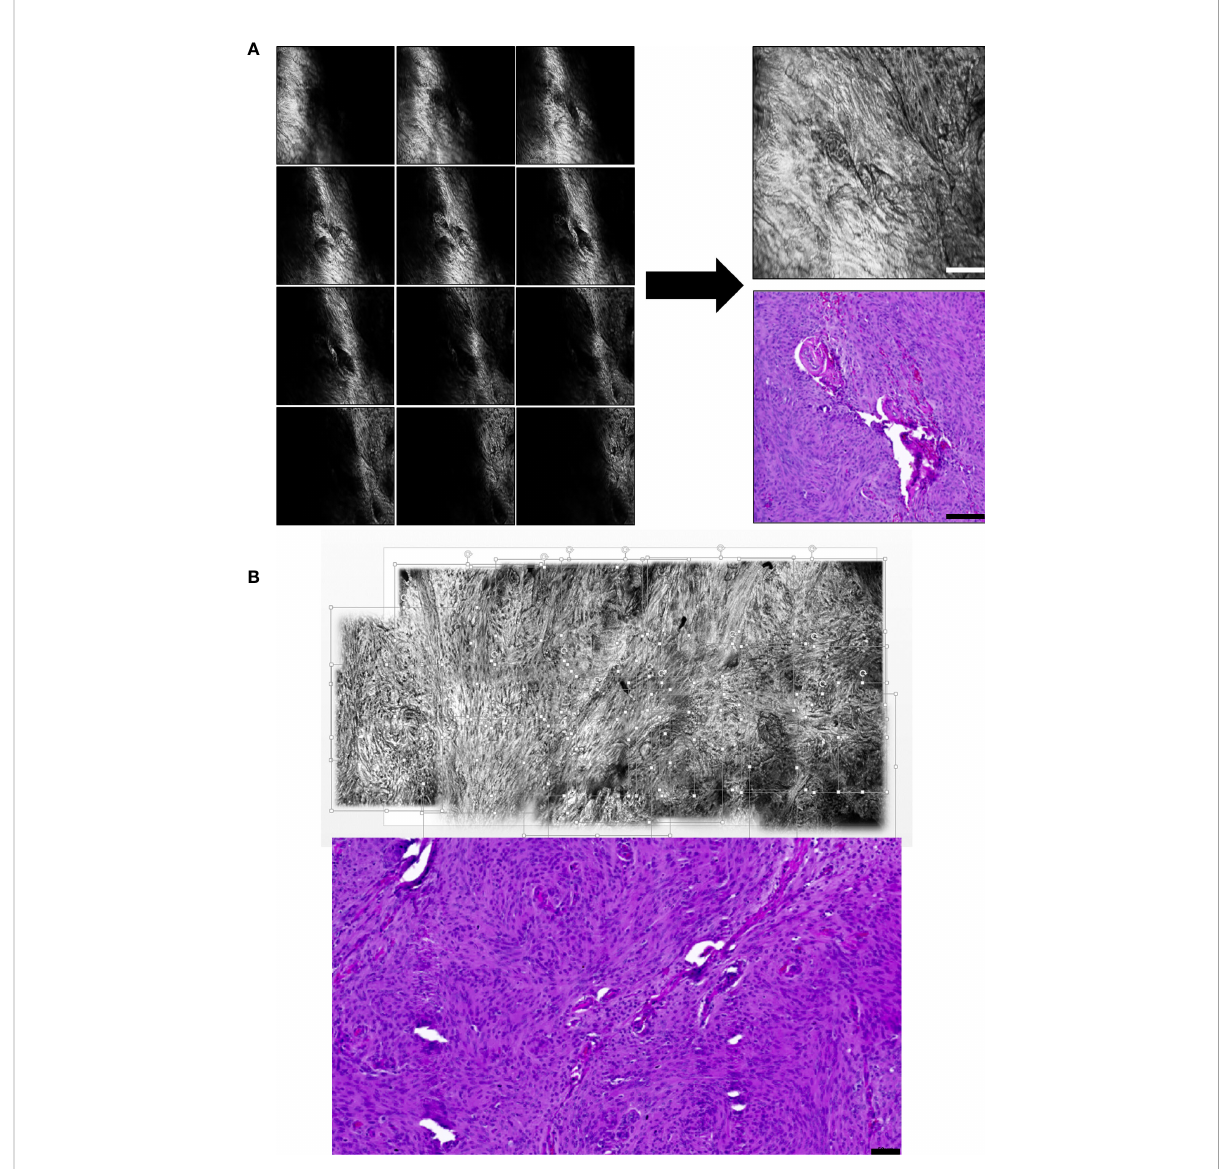
FIGURE 7 Panoramic CLE images with 3D depth information and their comparison with conventional hematoxylin and eosin stain A series of images taken while changing the distance between the probe and the tissue in the Z-axis were merged into one image (i.e., Z-merged). (A) The Z-merged CLE image and the histology of the benign meningioma tissue show similar microstructural features. (B) Using meningioma tissue, each Z-merged CLE image was combined into a panoramic image to provide a large fi eld of view as much as conventional H&E stain. Scale bar: 50 µm. H&E, hematoxylin and